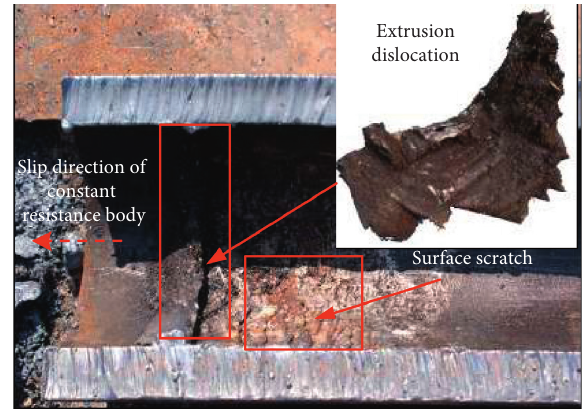
Figure 2: Empirical curve of elastic modulus-strand number relationship.